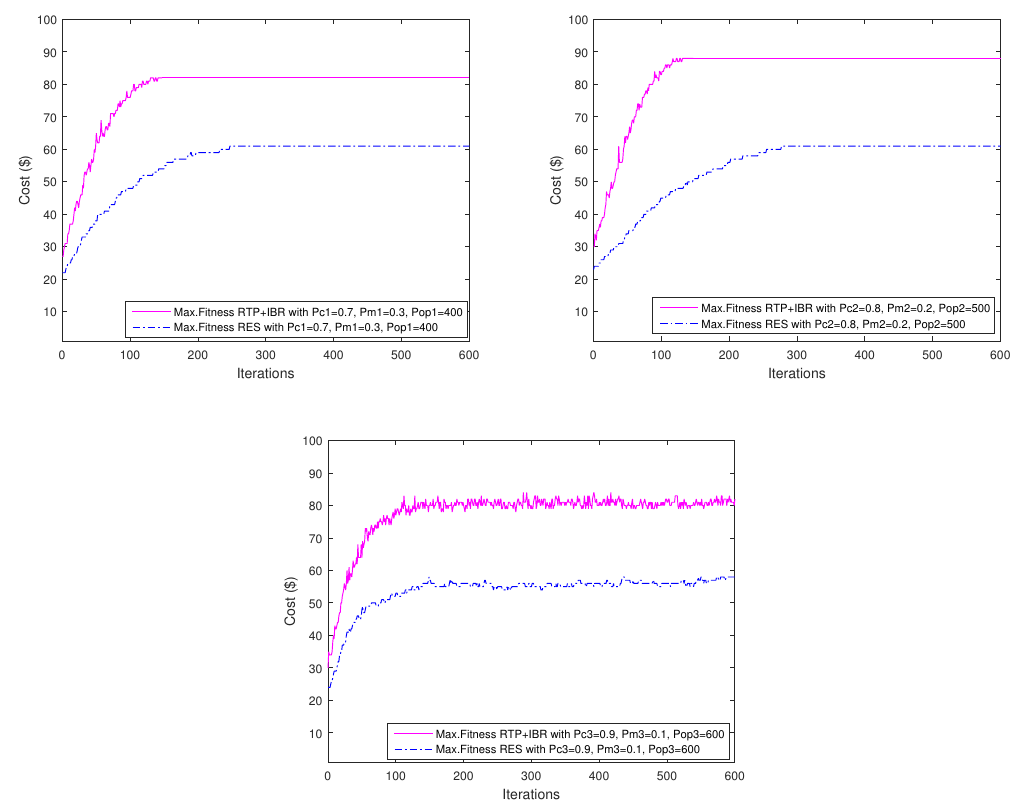
Figure 5. Convergence rate of GA against various parameters, i.e., P c , P m and pop size for the scheduled load with RTP+IBR and RTP+RES